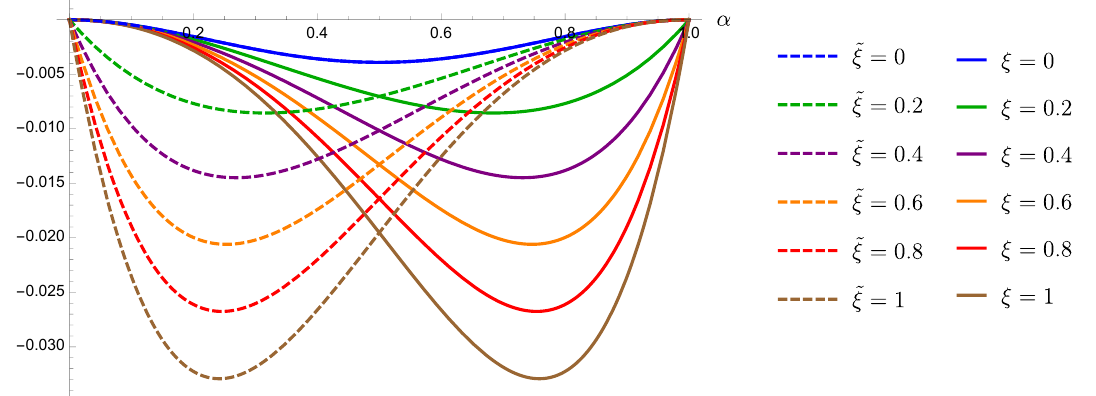
Figure 2 . Behavior of d 1 as a function of α for a monodromy defect in a theory of a single conformally coupled complex scalar in d = 6 , from eq. (5.19). The solid lines have fixed ˜ ξ = 0 and varying ξ , while the dashed lines have fixed ξ = 0 and varying ˜ ξ